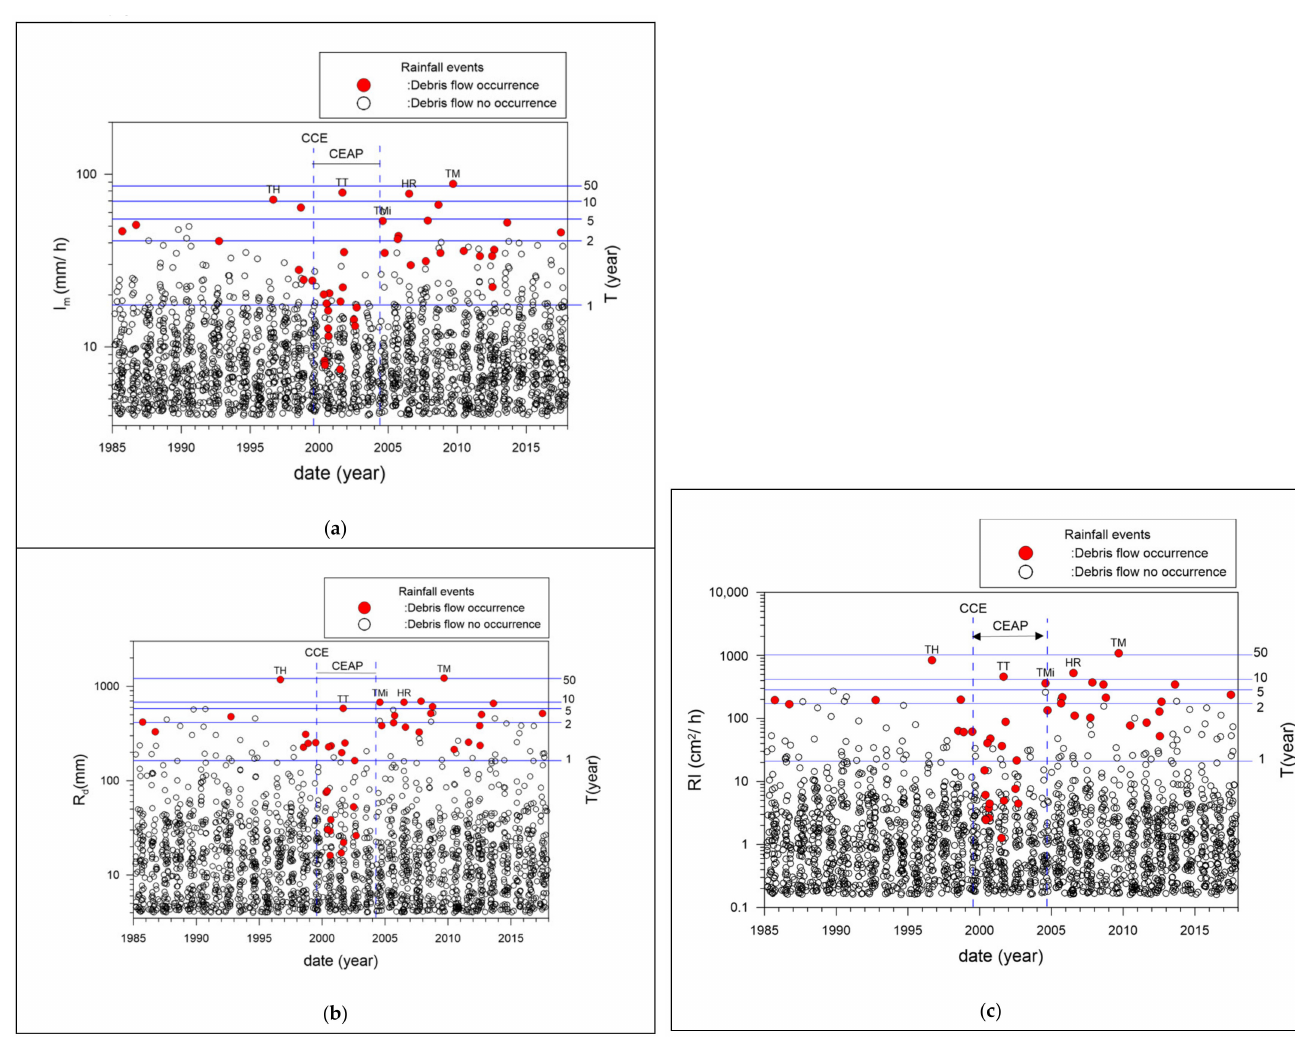
Figure 3. Rainfall events, using rainfall index of: ( a ) I m , ( b ) R d , and ( c ) RI, and rainfall-triggered debris flow events between 1985–2017. Data points show debris flow events triggering after the five extreme rainfall events TMi, TT, HR, TH, and TM, Chi-Chi earthquake (CCE), and during the CCE-affected period